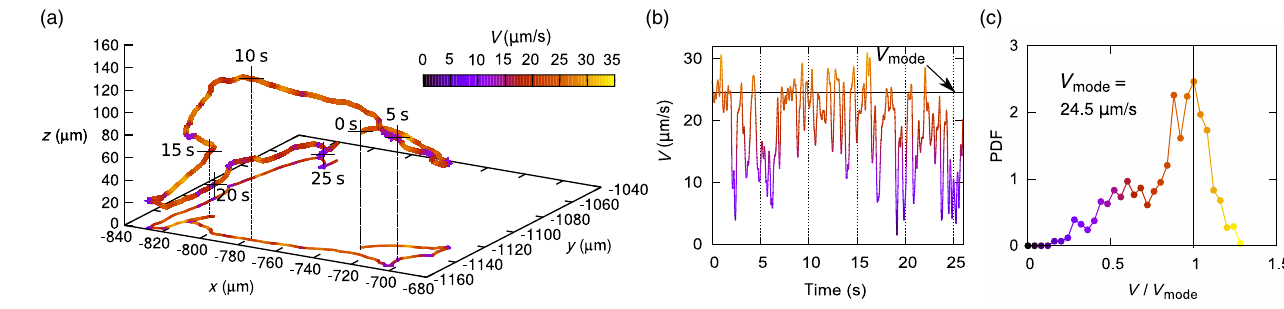
FIG. 2. Details of a typical trajectory. (a) 3D trajectory and its projection on the x - y plane, (b) velocity vs time, and (c) velocity distribution. The marks every 5 s in the 3D track are references for comparison with